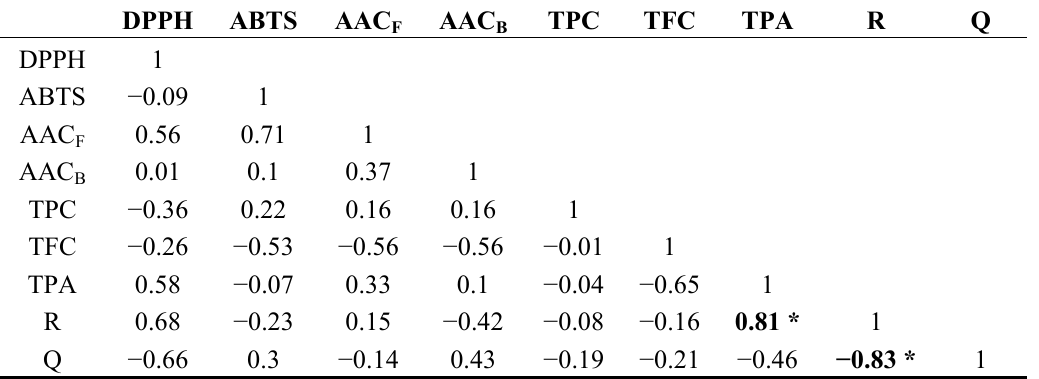
Table 5. Significant correlations between antioxidant properties for 6 tartary buckwheat samples. DPPH ABTS AAC AAC TPC TFC TPA R Q F B DPPH 1 ABTS − 0.09 1 0.56 0.71 1 AAC F 0.01 0.1 0.37 1 AAC B TPC − 0.36 0.22 0.16 0.16 1 TFC − 0.26 − 0.53 − 0.56 − 0.56 − 0.01 1 TPA 0.58 − 0.07 0.33 0.1 − 0.04 − 0.65 1 R 0.68 − 0.23 0.15 − 0.42 − 0.08 − 0.16 0.81 * 1 Q − 0.66 0.3 − 0.14 0.43 − 0.19 − 0.21 − 0.46 − 0.83 * 1 Results expressed as Pearson correlation coefficients with indicated level of significance. Data with asterisks were significant at P < 0.05. DPPH, DPPH  scavenging activity; ABTS, ABTS  + scavenging activity; AAC , antioxidant activity coefficient of free phenolics; AAC , antioxidant F B activity coefficient of bound phenolics; TPC, total phenolic content; TFC, total flavonoid content; TPA, total phenolic acid; R, rutin; Q,